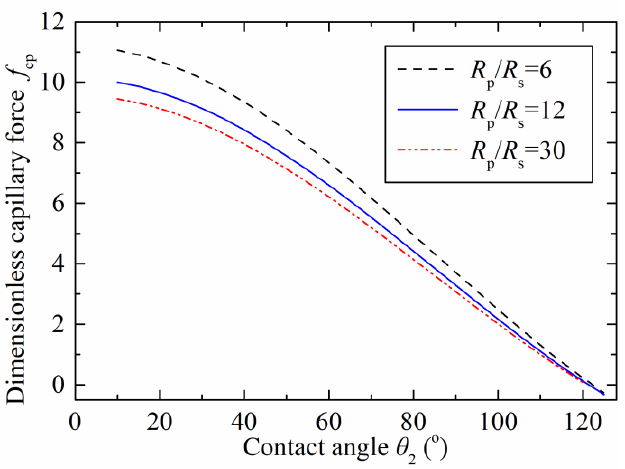
Figure 4. Effects of contact angle on the dimensionless capillary force.